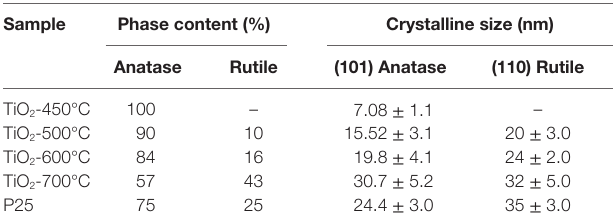
TaBle 1 | The size and phase composition of TiO 2